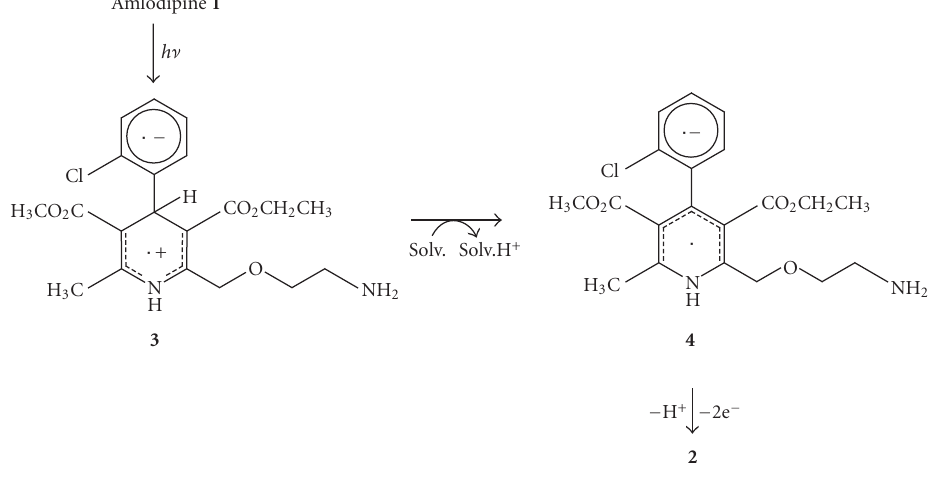
Scheme 2: Mechanistic hypothesis for compound 2